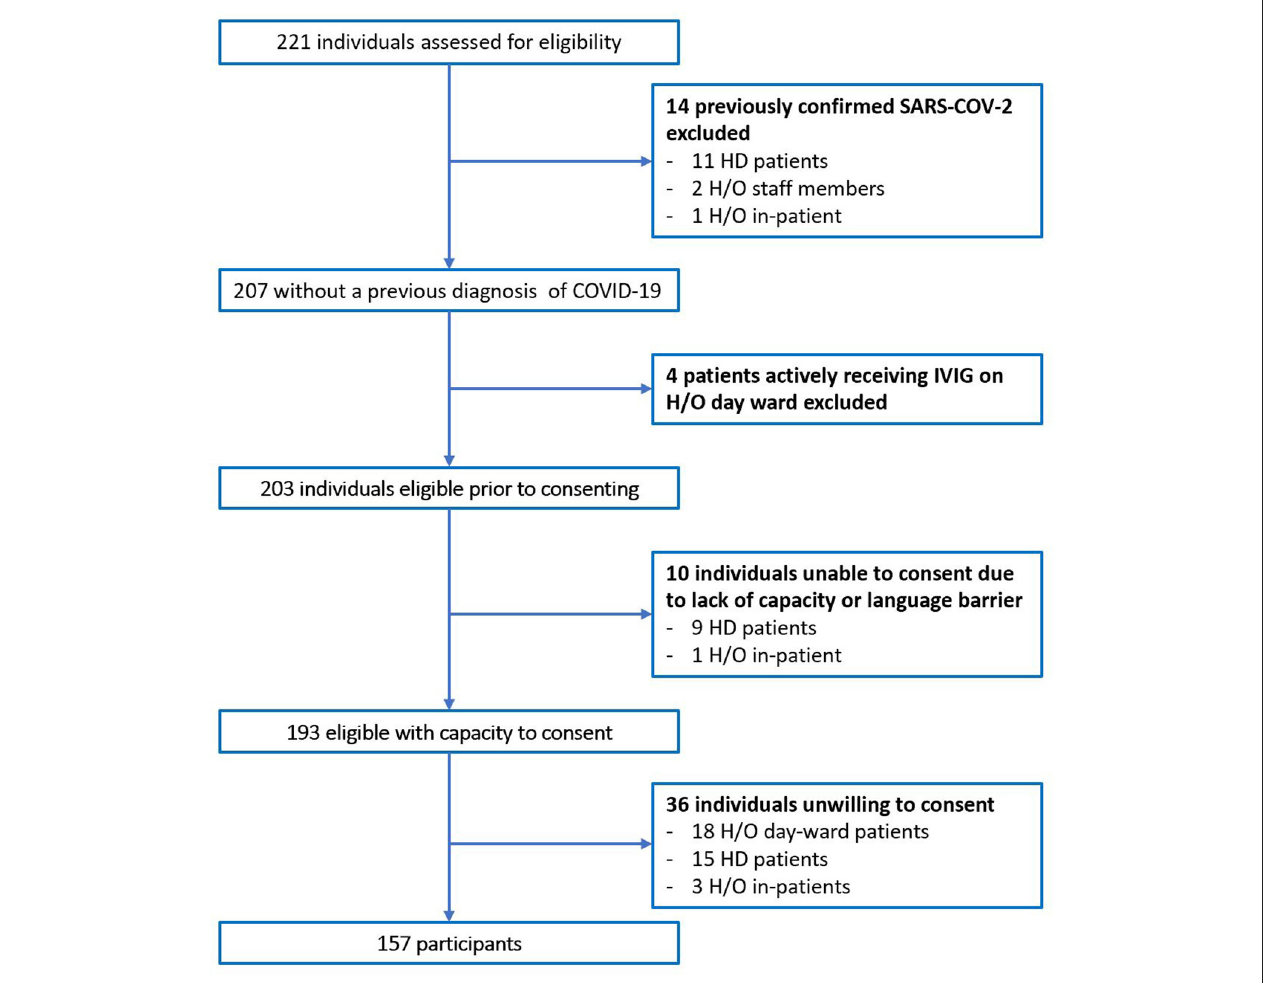
FIGURE 1 | Flow diagram of excluded